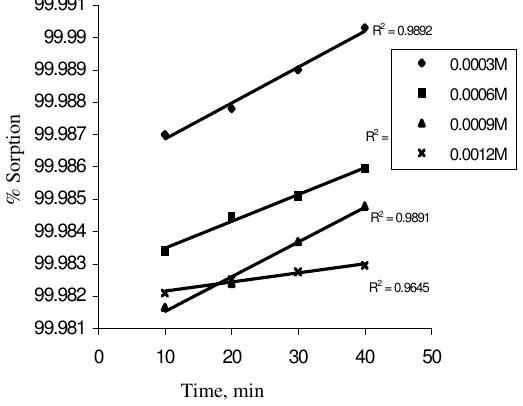
Figure 2 . Variation of % of Pb ion adsorbed by oyster shell with